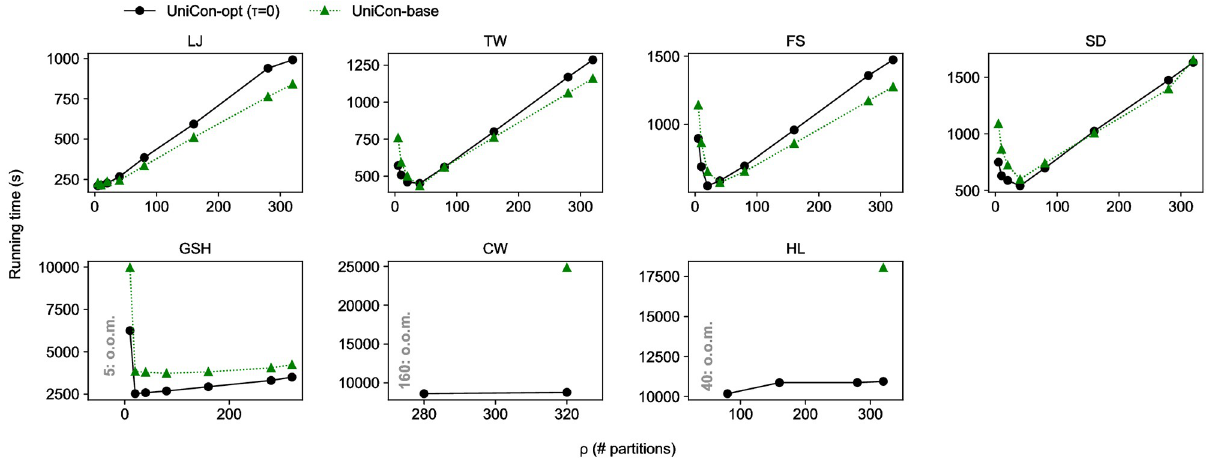
Fig 7. The running time of UniCon-opt and UniCon-base on various partition number ρ . With large data like GSH, CW, and HL, when ρ is greater than each optimal value, the running time of UniCon increases marginally as ρ increases.